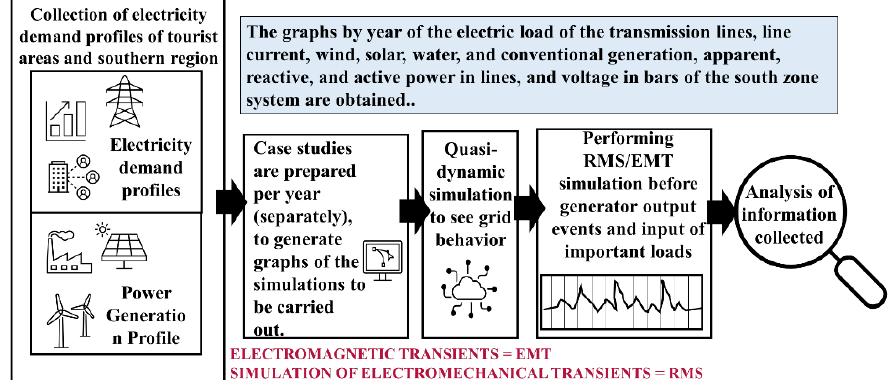
Figure 1. Methodology used.